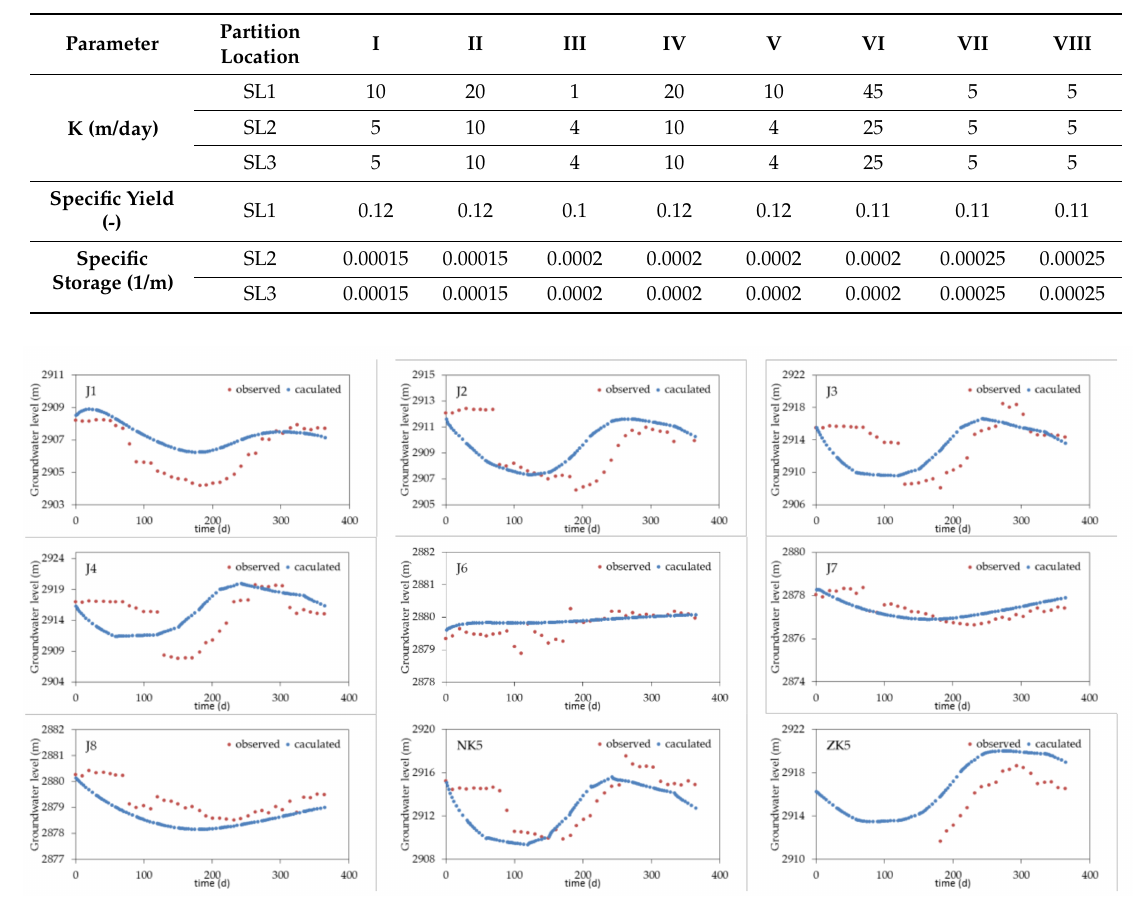
Figure 15. Curves fitted to groundwater observation wells in the calibration